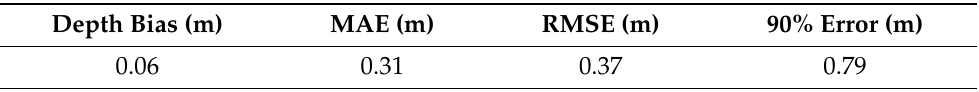
Table 1. The depth bias, mean absolute error, RMSE (pixel-wise), and the 90th percentile error over the test set (Duck, NC